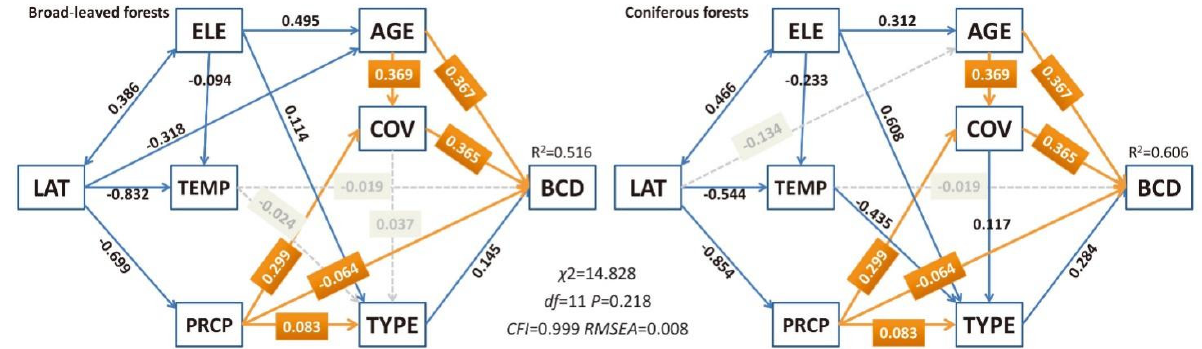
Figure 5. Multi − group structural equation model for natural broad − leaved and coniferous forests. The factors influencing the biomass carbon density (BCD) of natural broad-leaved and coniferous forests include stand age (AGE), stand coverage (COV), forest type (TYPE), elevation (ELE), latitude (LAT), annual mean temperature (TEMP), and annual mean precipitation (PRCP). Solid arrows indicate significant paths ( p < 0.05), while dashed arrows are non-significant paths. The numbers along the arrows are standardized regression weights indicating the effect size. R 2 denotes the proportion of variation explained. Orange arrows represent equal effects between broad-leaved and coniferous forests; while blue arrows represent unequal effects between them.